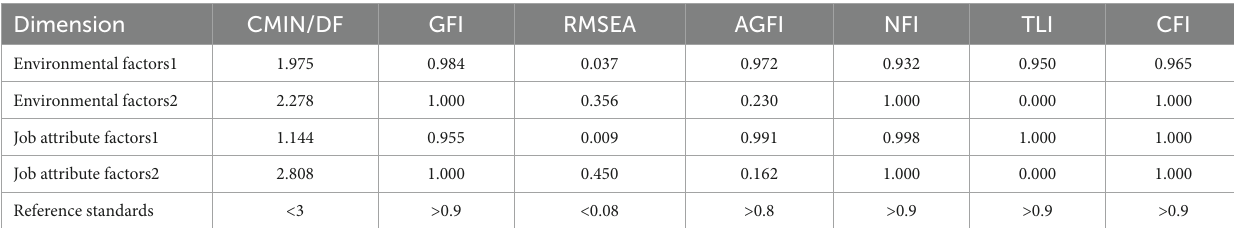
TABLE 4 Validation factor analysis.